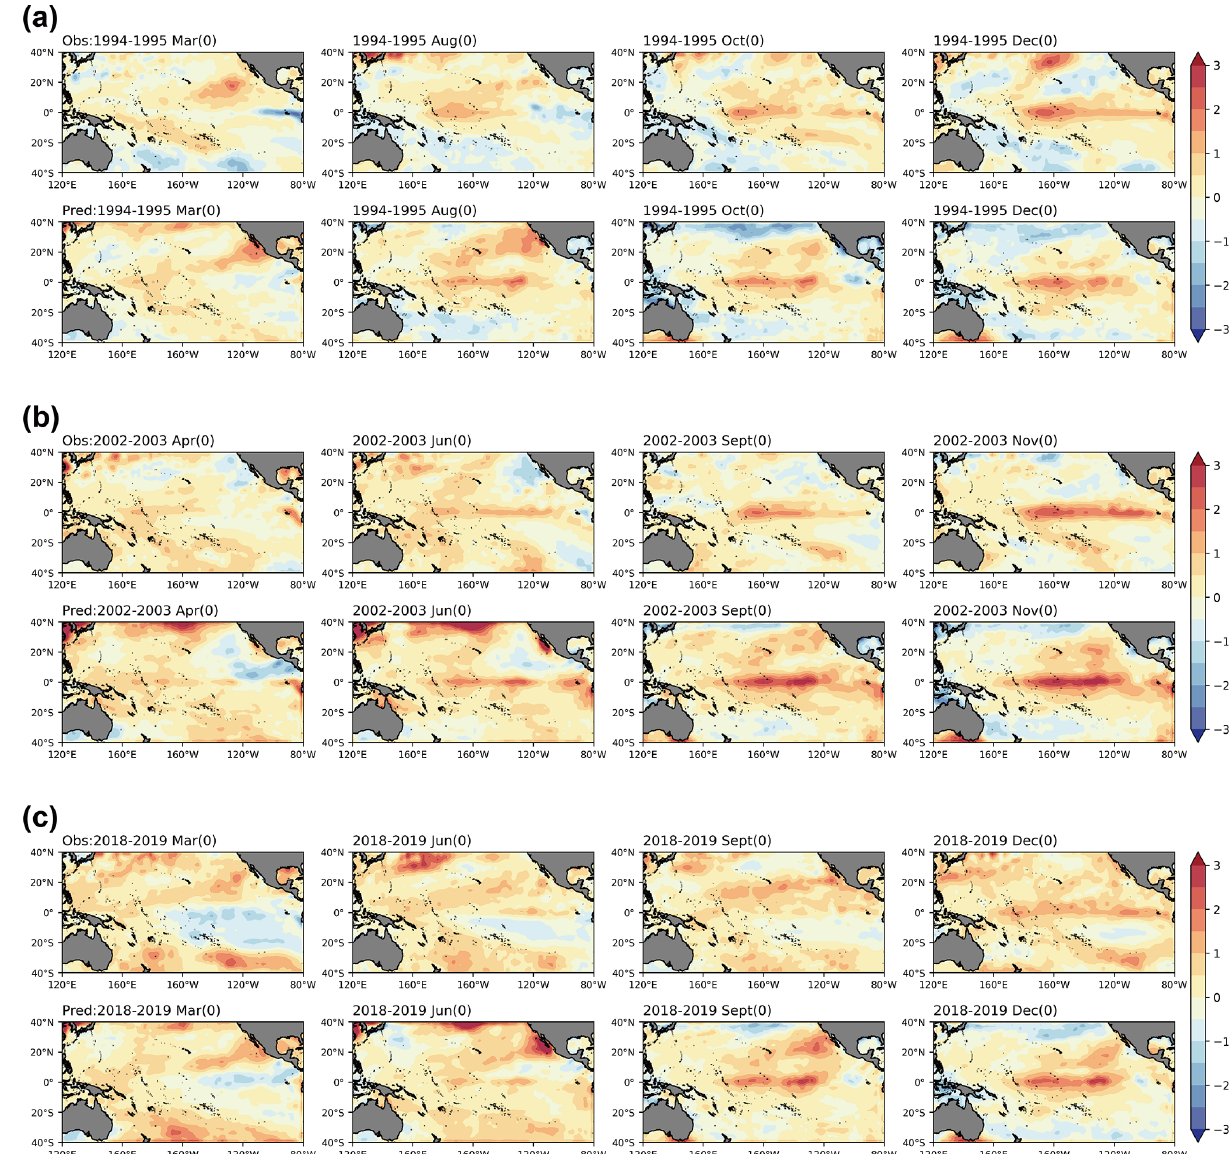
Figure 10. The same as in Fig. 9, but for the three CP El Niño events in (a) 1994–1995, (b) 2002–2003 and (c)